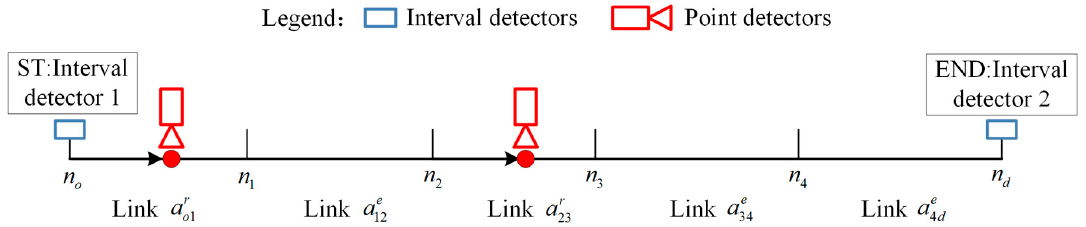
Figure 1. Illustrative example of the heterogeneous data fusion problem.